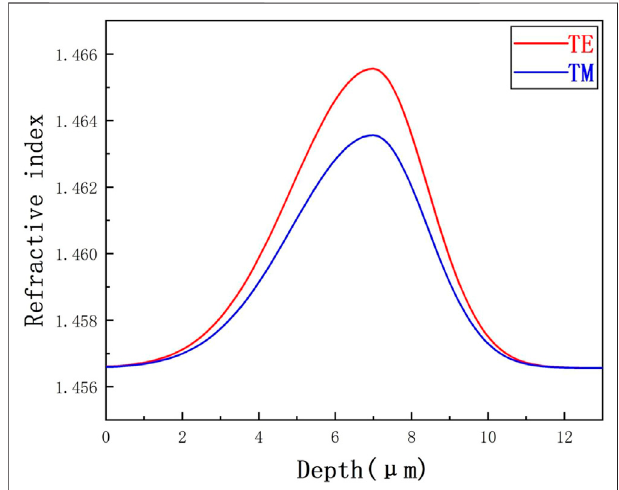
FIGURE 2 | Refractive index pro fi le on TE (red line) and TM (blue line) modes at 4 μ m wavelength of the 15 MeV C 5+ ion irradiated BaF 2 crystal.